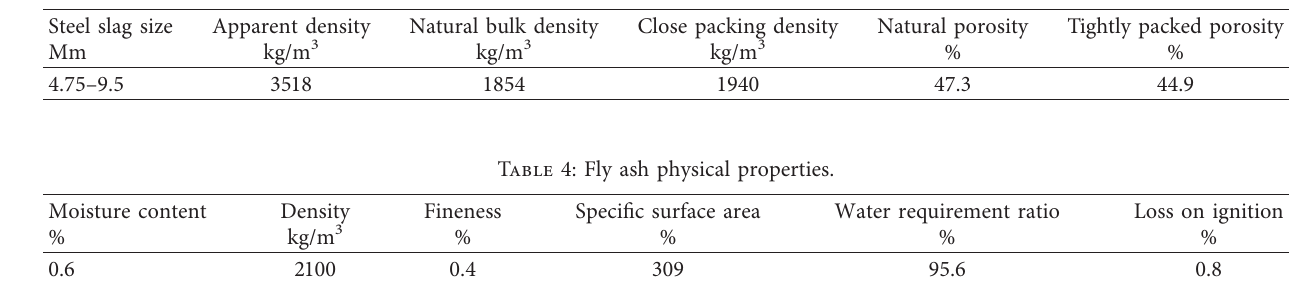
Table 3: Physical properties of steel slag aggregates.